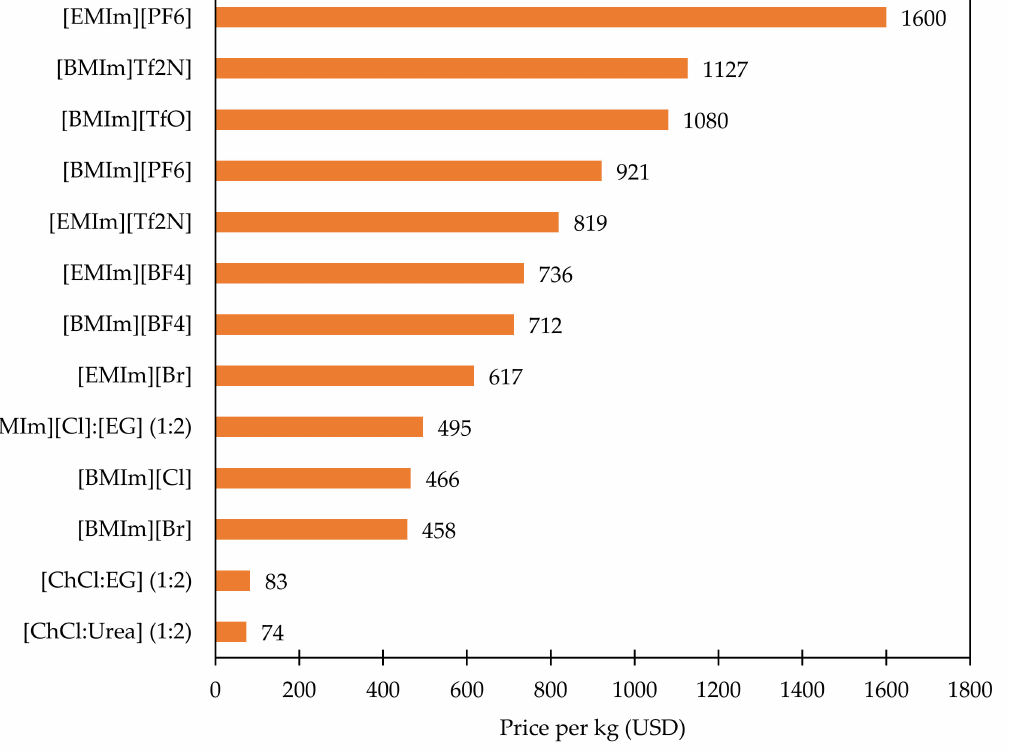
Figure 6. Plot comparing the cost of ILs, DESs in USD per kg based on commercial